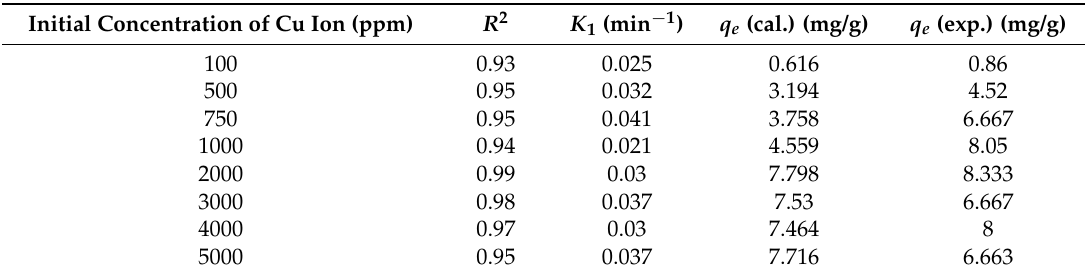
Estimated kinetic parameters for the first-order rate kinetic model at different copper concentrations.